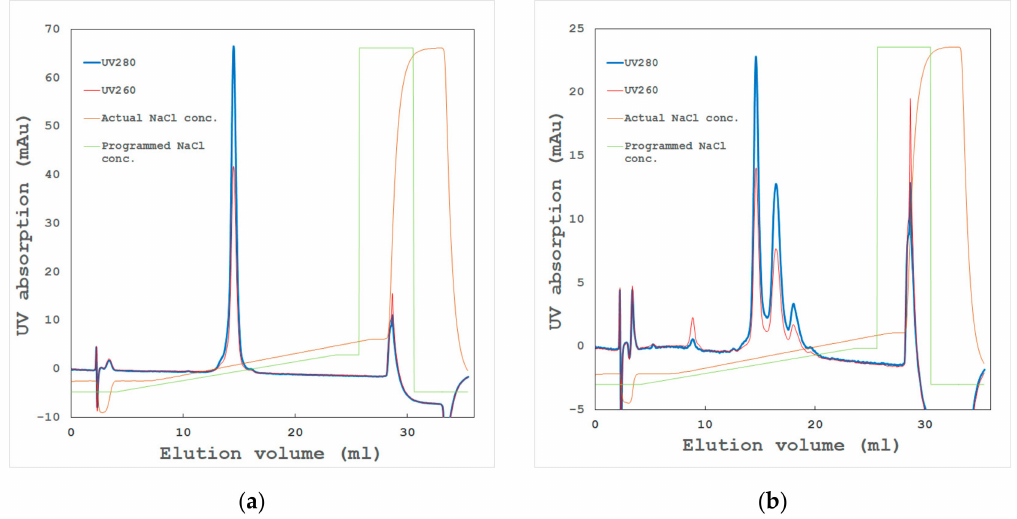
Figure 5. Typical chromatograms of ion-exchange chromatography. Blue and red lines show UV absorption at 280 and 260 nm, respectively. Brown and green lines show the actual and programmed sodium chloride concentration, respectively. The gradient of sodium chloride is commonly used for elution from the column [15]. There are various kinds of ion exchange resins with di ff erent chromatographic particles (e.g., a quaternary ammonium group and a carboxymethyl group)